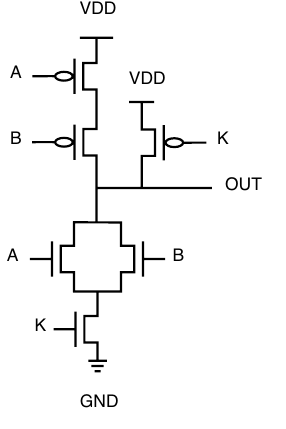
Figure 7. NOR gate.